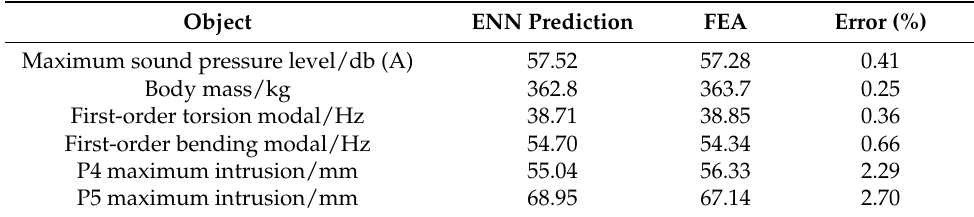
Table 6. Comparison between Elman neural network prediction and finite element calculation.